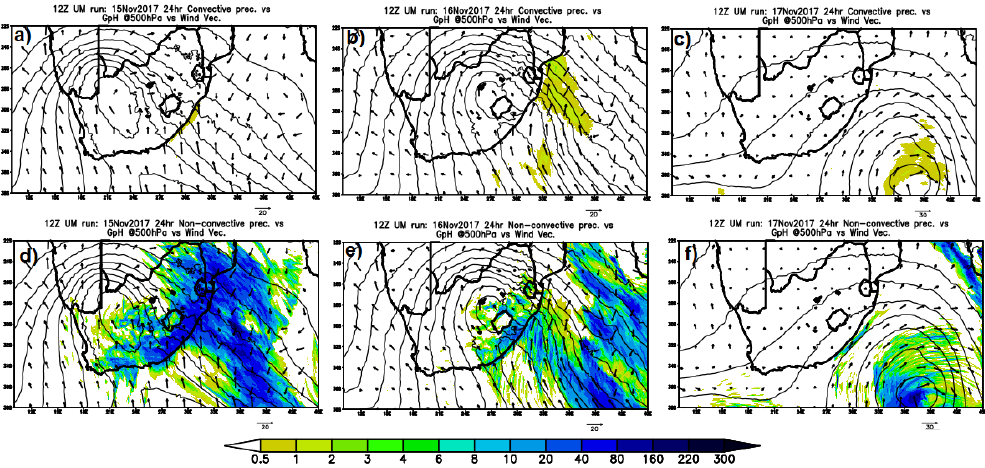
Figure 9. Geopotential heights at 500 hPa (thin contours) together with convection precipitation ( a , b , c ) at 12Z UM 24 h on the 15th, 16th and 17th Nov. 2017. Bottom panels ( d , e , f ) are for the same time as in ( a , b , c ) but for non-convective precipitation. The vectors represent the wind vectors at 10 m above the ground.